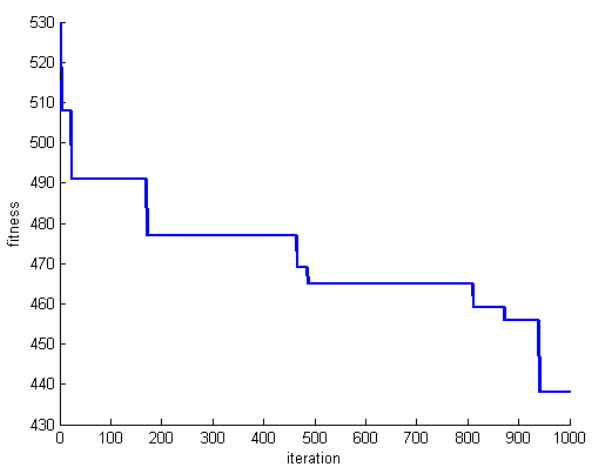
Figure 12. Changes of the best whale for 2 = a in